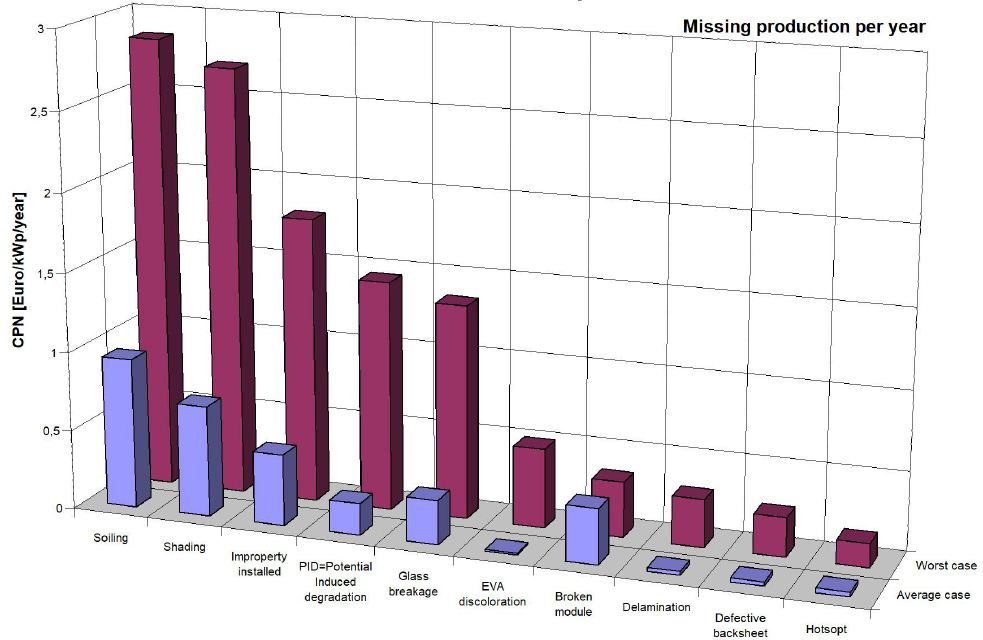
Figure 1. Missing electricity production due to various types of failure of solar panels